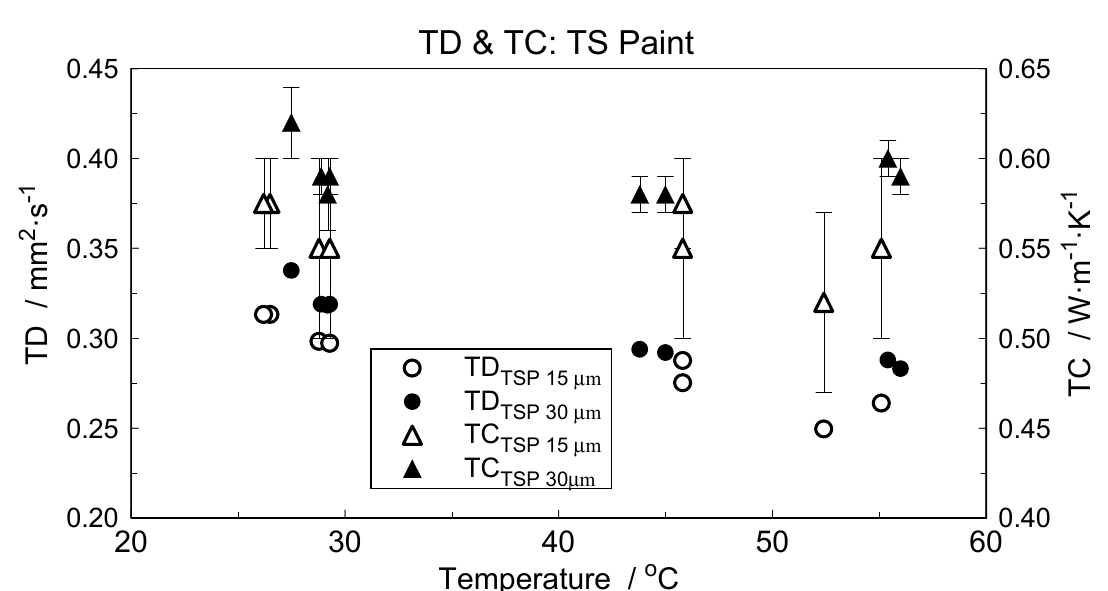
Figure 9. Estimated TSP thermal diffusivity (TD) and thermal conductivity (TC) of TSP.